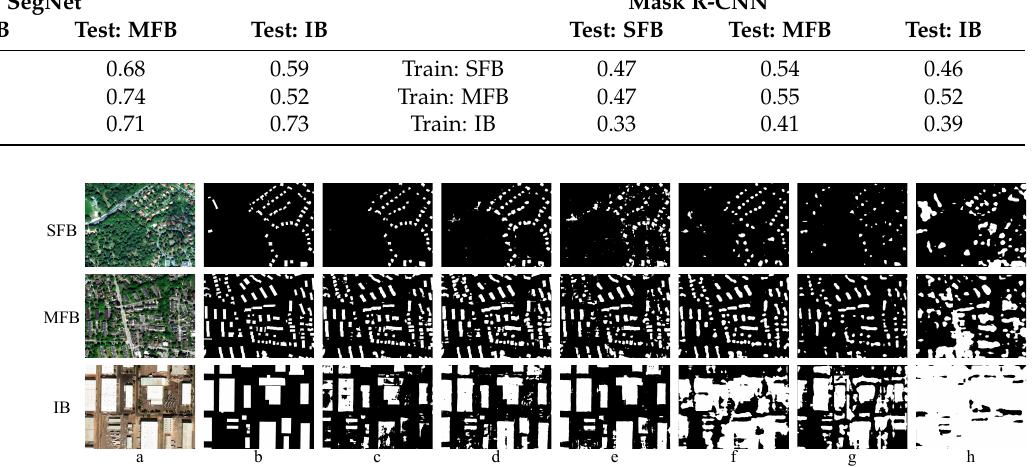
Figure 11. Robustness to different building structures (RQ5): three image examples from the test sets with single family buildings (SFB), multiple family buildings (MFB), and industrial buildings (IB) together with the predicted masks by the models: ( a ) input image; ( b ) ground truth; ( c ) SegNet trained on SFB; ( d ) SegNet trained on MFB; ( e ) SegNet trained on IB; ( f ) Mask R-CNN trained on SFB; ( g ) Mask R-CNN trained on MFB; ( h ) Mask R-CNN trained on